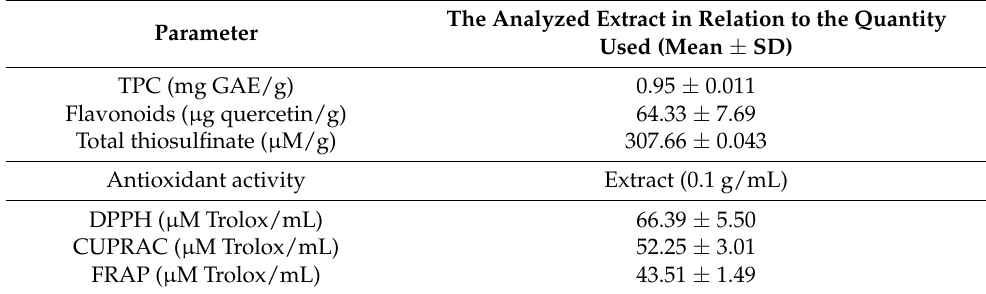
Table 1. The total polyphenol content (TPC) and antioxidant activity obtained by different methods.